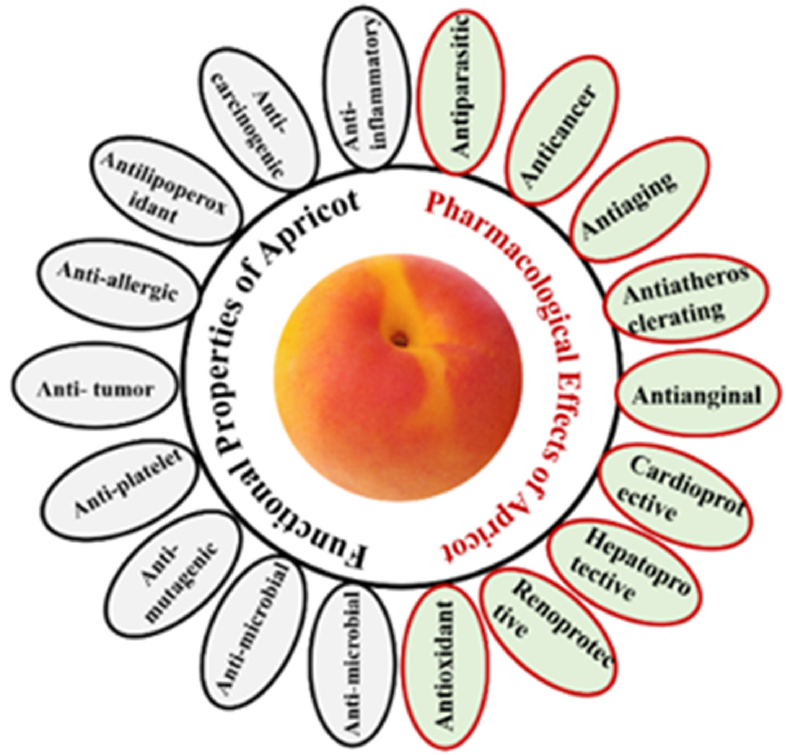
Figure 5. Functional Properties and Pharmacological Effects of Apricot [3,24].